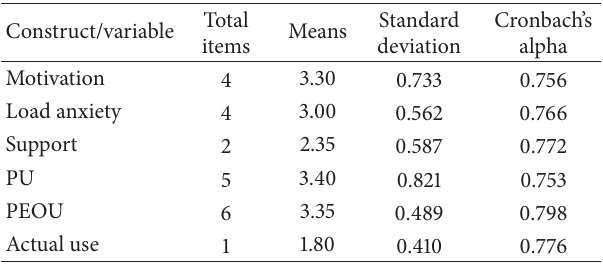
Table 2: Internal consistency reliability